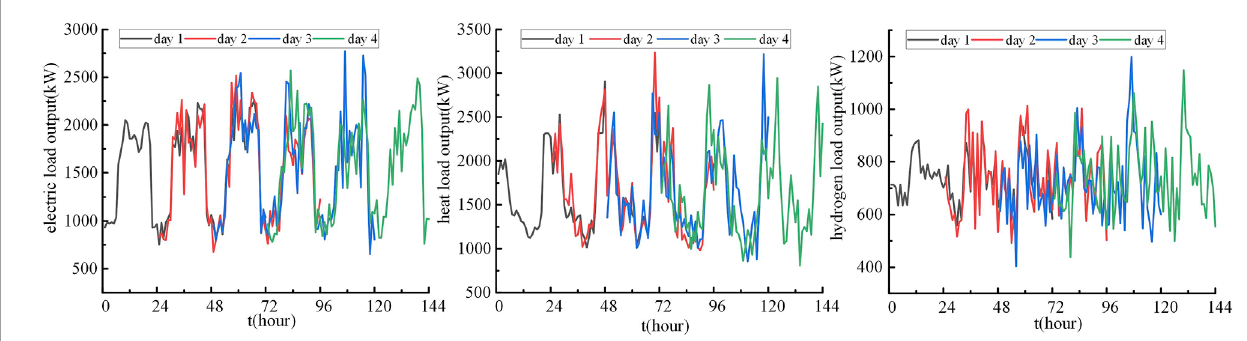
FIGURE 5 Electricity-heat-hydrogen load forecast information.